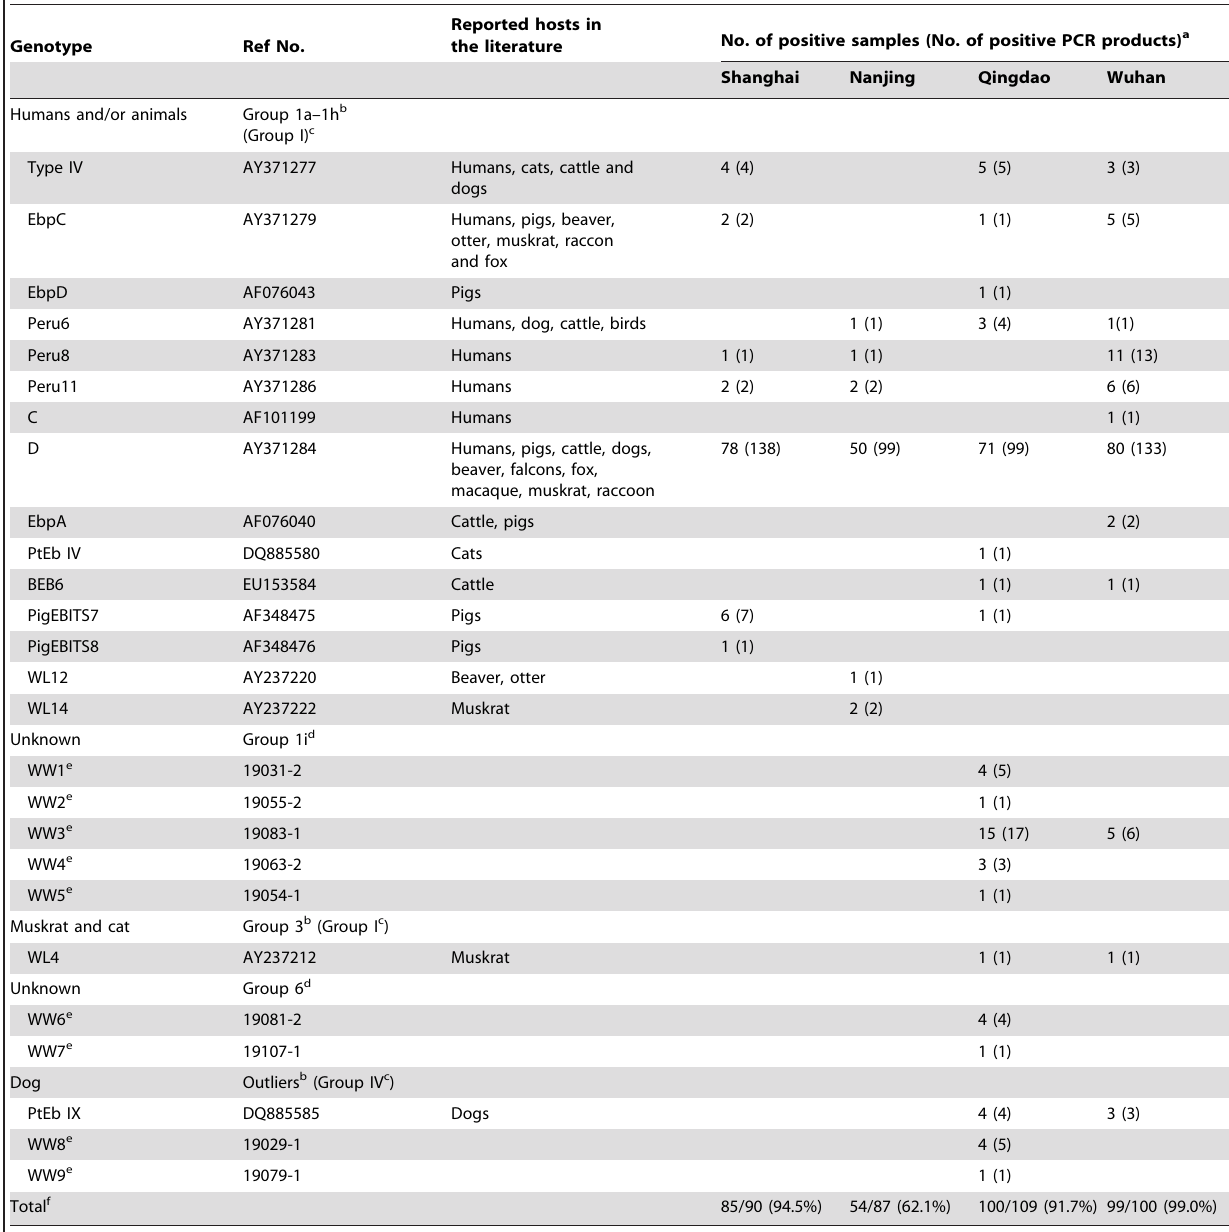
Table 3. Enterocytozoon bieneusi ITS genotypes in wastewater samples of four cities in China during 2006–2009 a .